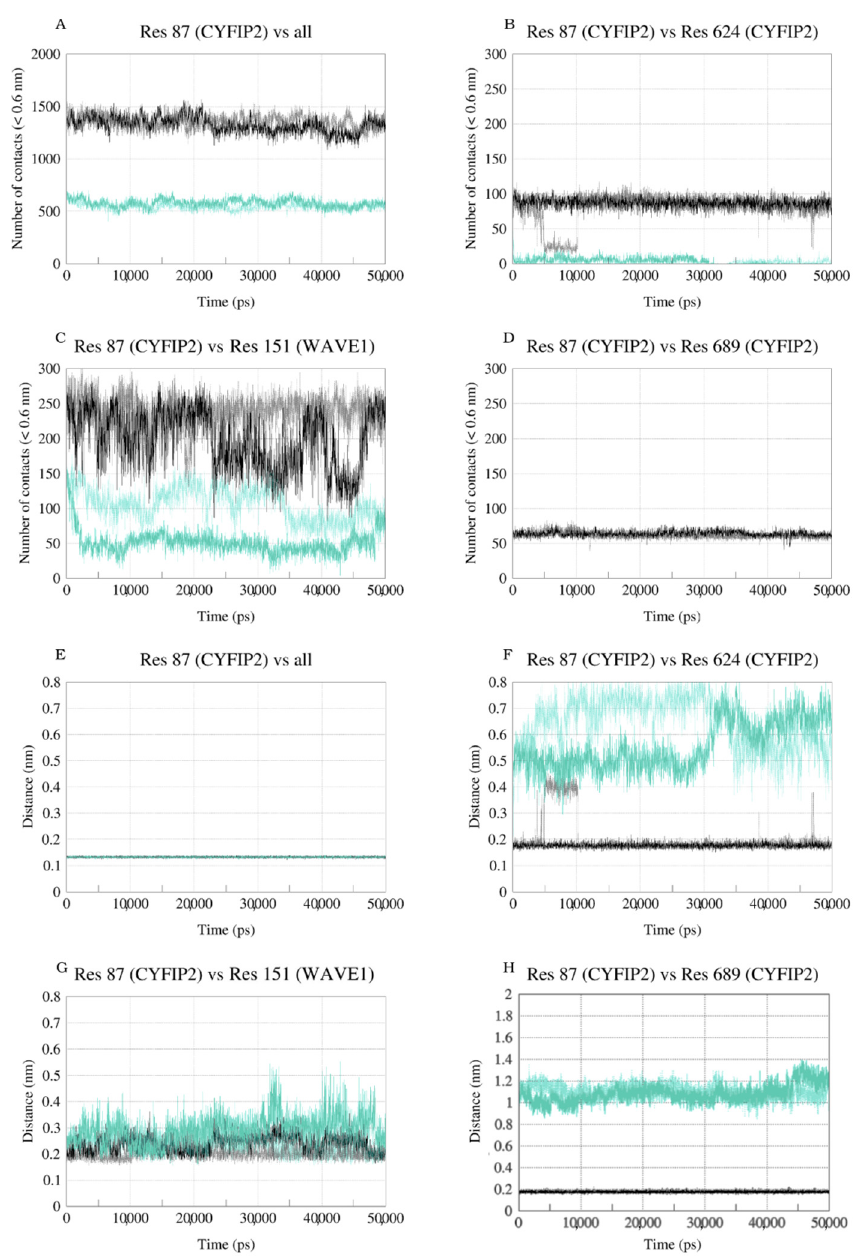
Figure 7. Number of contacts between residue R/C87 and all other residues ( A ), E624 CYFIP2 ( B ), Y151 WAVE1 ( C ), and E689 CYFIP2 ( D ) as a function of simulation time (ps). Minimal distance between residue R/C87 and all other residues ( E ), E624 CYFIP2 ( F ), Y151 WAVE1 ( G ), and E689 CYFIP2 ( H ) as a function of simulation time (ps). Data for complex WT simulation are represented by dark (first replica) and light (second replica) gray lines. Data for complex R87C simulation are represented by dark (first replica) and light (second replica) cyan lines.